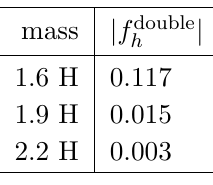
Table 4 . NG mediated by h via double exchange diagram in single-(cid:12)eld slow-roll in(cid:13)ation.